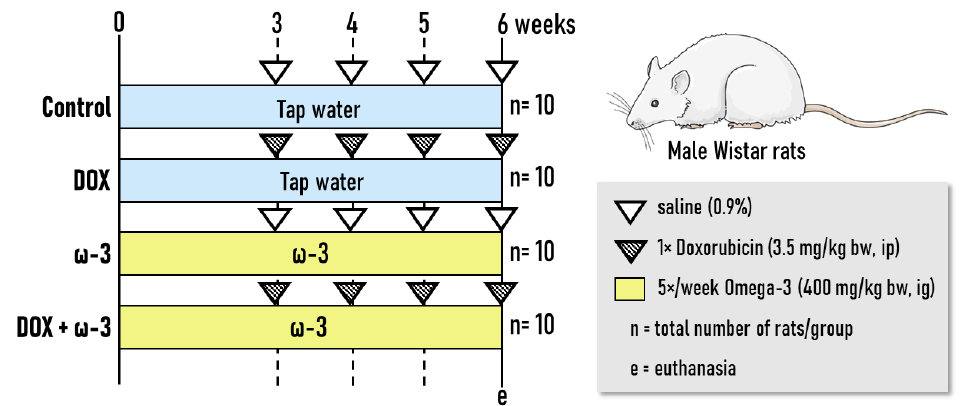
Figure 6. Experimental design. This figure was composed with the aid of SMARTServier